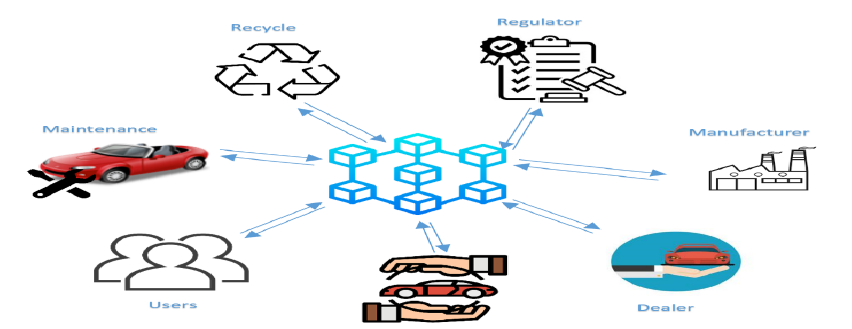
Figure 7. Recall process after manually reporting from the maintenance center.